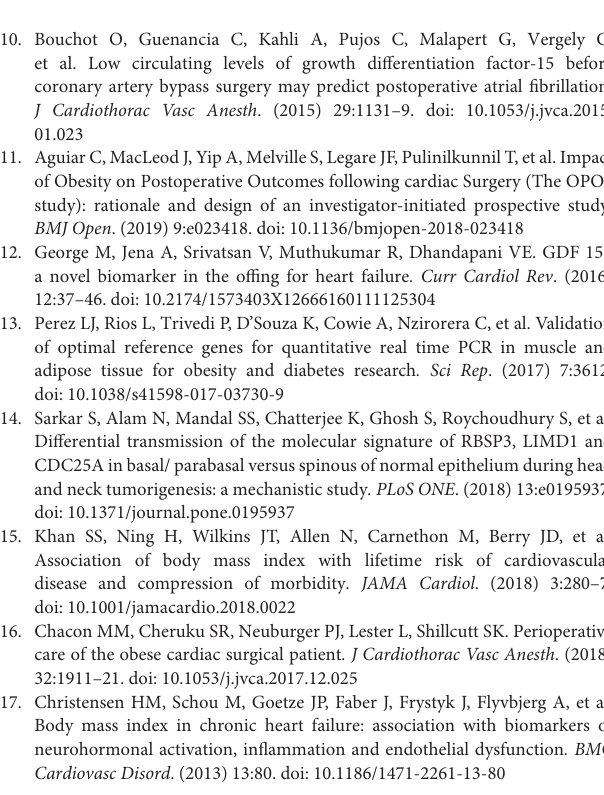
Supplementary Figure 1 | (A) Atrial GDF15 showed low mRNA expression. mRNA expression was normalized to YWHAZ. (B) Atrial GDF15 mRNA did not show a significant association with plasma GDF15 (i) or atrial GDF15 protein expression (ii) . Supplementary Table 1 | Patient characteristics when divided on the basis of high and low